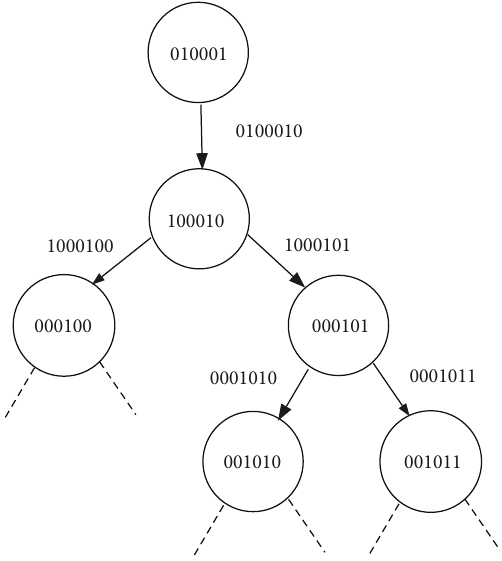
Figure 8: Process to determine the evolution rule following a path in the De Bruijn